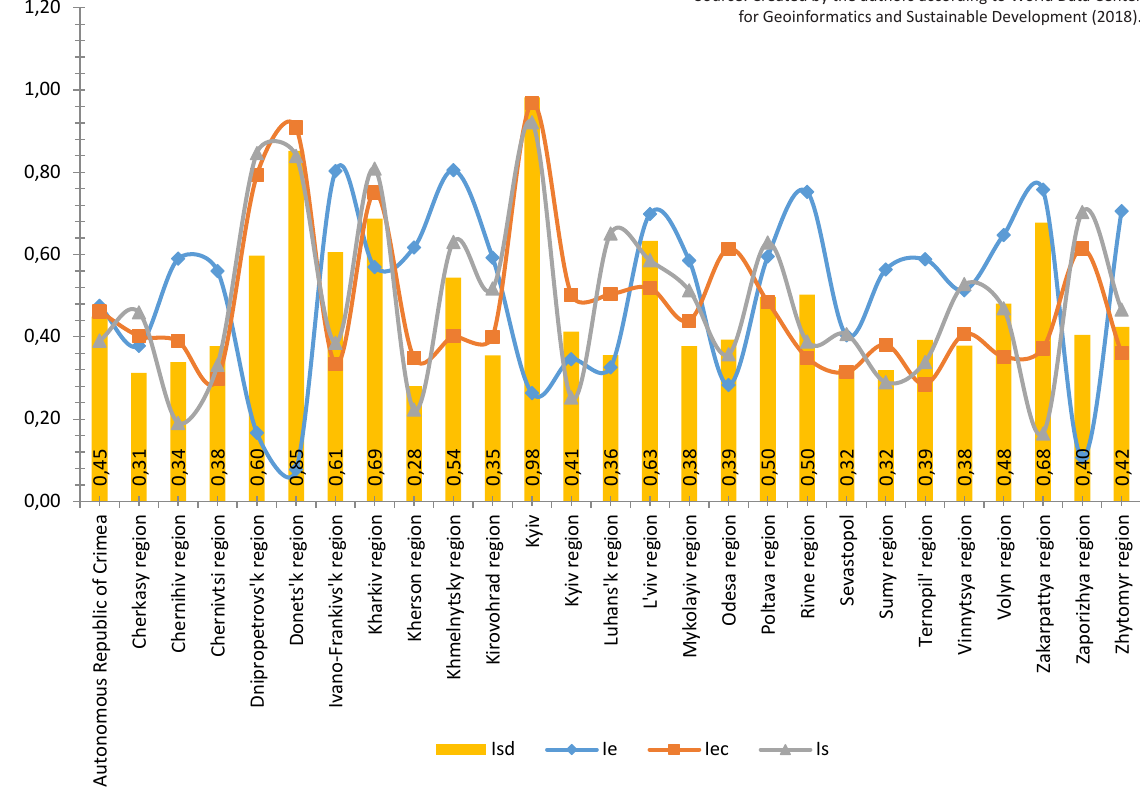
Figure 2. Sustainable development index and indices of social,